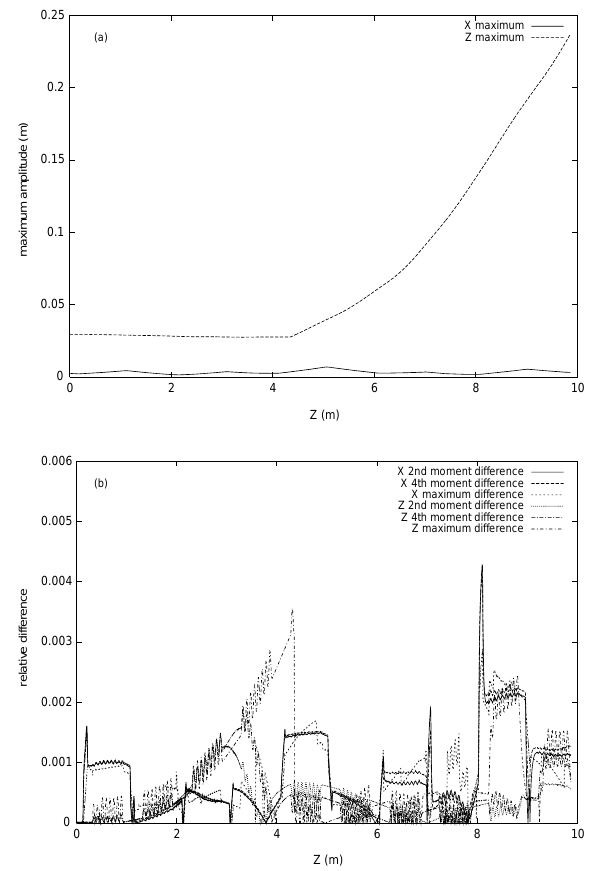
FIG. 10. The relative difference and maximum particle ampli- tude as a function of position using zeroth-order transformation in the reference